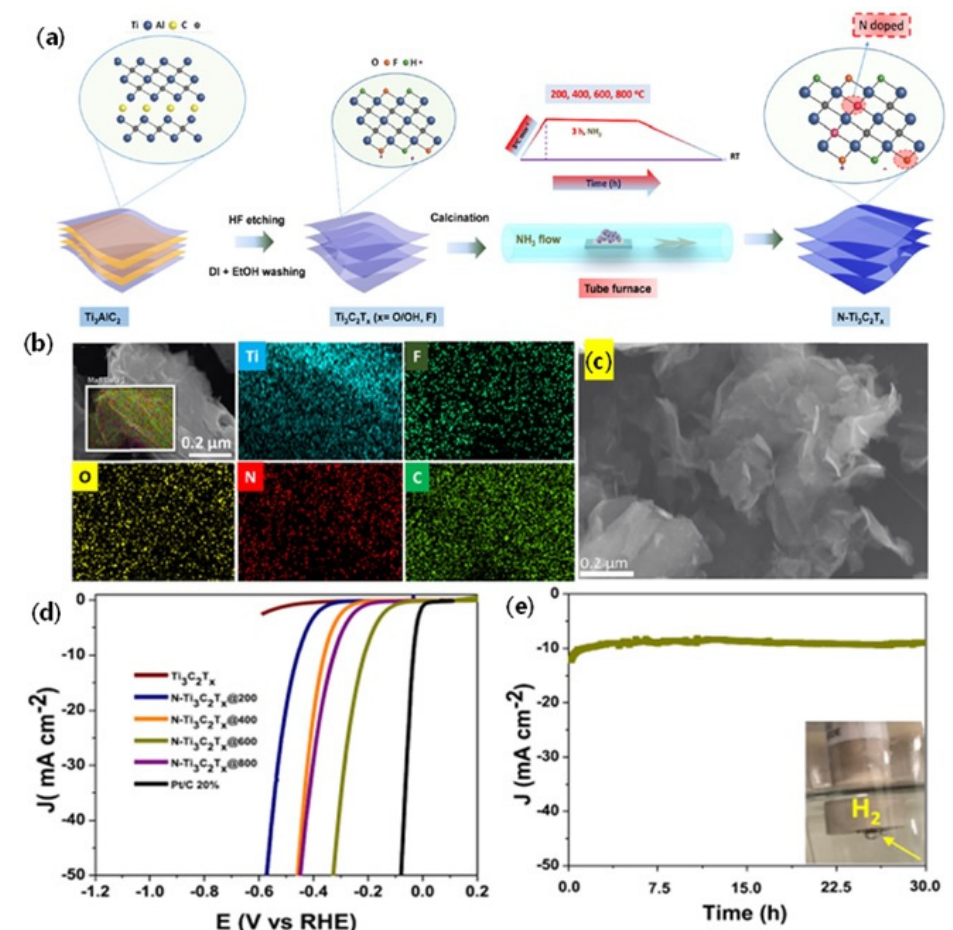
Figure 7. ( a ) Illustration of synthesis of N-doped MXene from the Ti 3 AlC 2 MAX phase. ( b ) SEM–EDX elemental mapping of N − Ti 3 C 2 T x 600 and ( c ) SEM image of delaminated N − Ti 3 C 2 T x @600. ( d ) HER polarization curves of Ti 3 C 2 T x and a series of different N-doped Ti 3 C 2 T x catalysts. ( e ) Test at a constant overpotential of − 0.19 V (inset: photo of a rotating disk electrode (RDE) with the produced H 2 bubbles on its surface). Reprinted with permission from Ref. [78]. Copyright 2019, American Chemical Society.